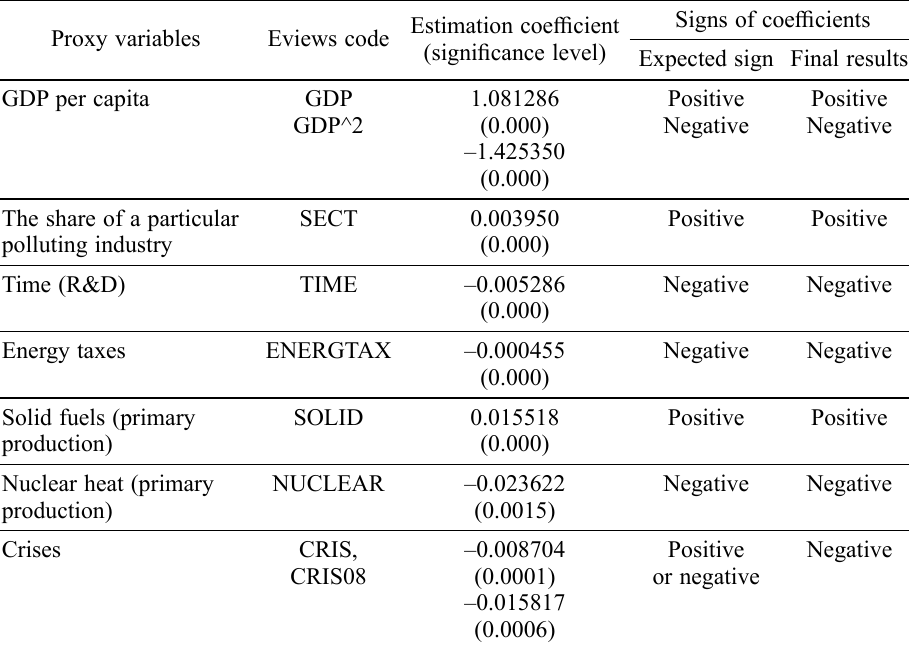
Table 4. Comparison of expected and obtained coefficient signs Proxy